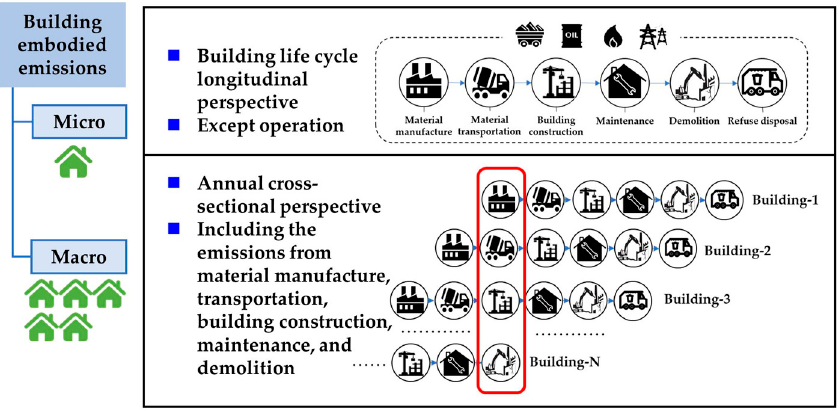
Figure 2. The comparison of building embodied emissions at the micro and macro levels.